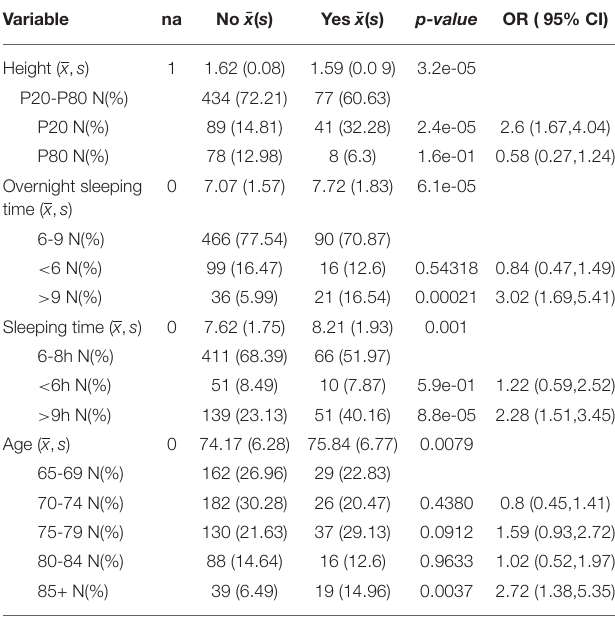
TABLE 2 | Description of significant quantitative variables for a univariate logistic regression with a significance level α =